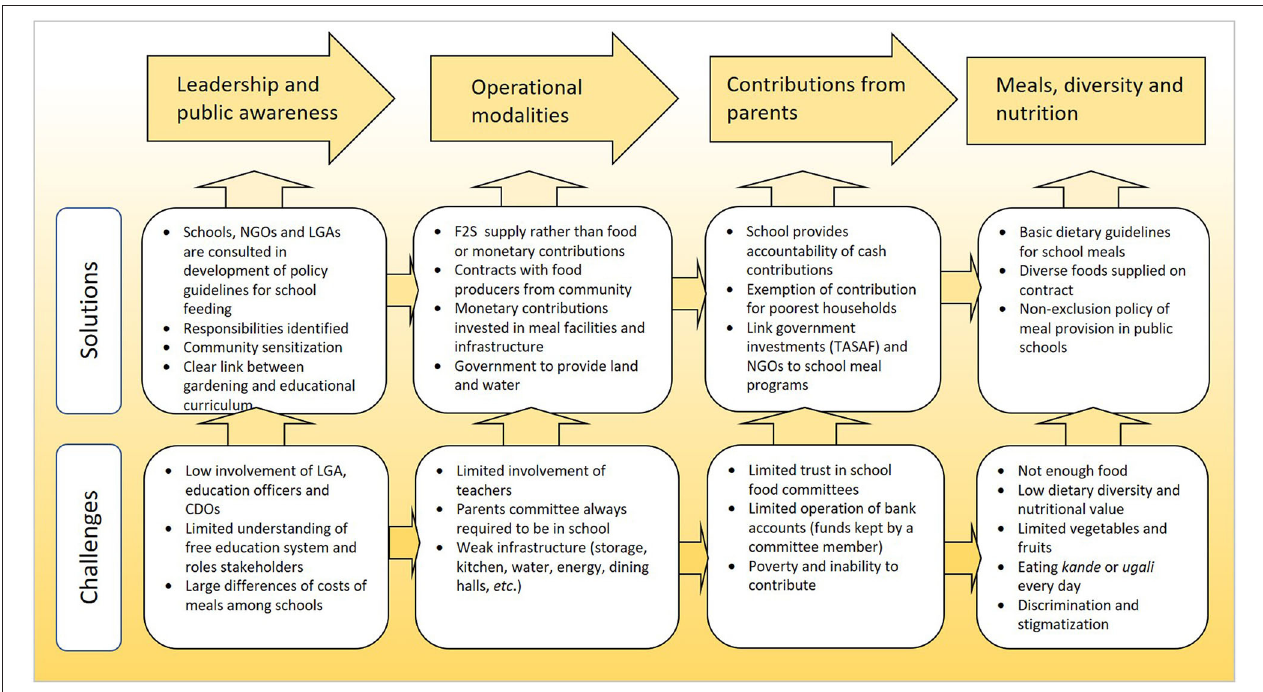
FIGURE 3 | Conceptual framework for planning and delivering nutritious meals in